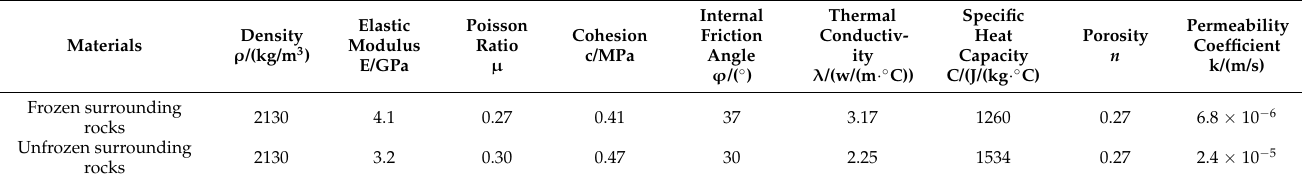
Table 2. Parameters of wall